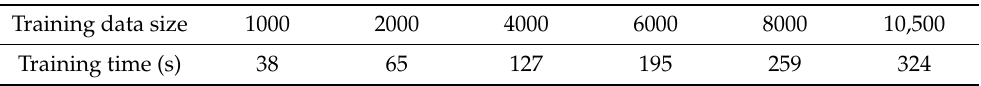
Table 1. Training time of DA for varying training dataset